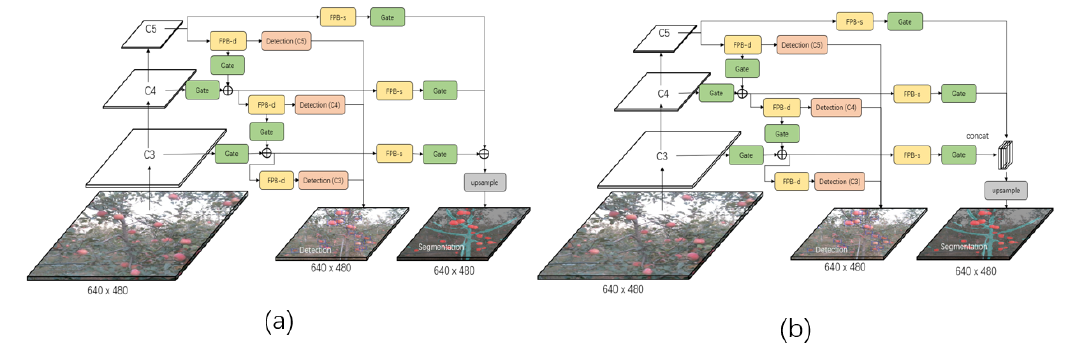
Figure 9. The architecture of DaSNet-B-Add ( a ) and DaSNet-B-concat ( b ). DaSNet-B-Add model uses adding operation to fuse the feature maps for segmentation, while DaSNet-B-Concat model uses concatenate operation.